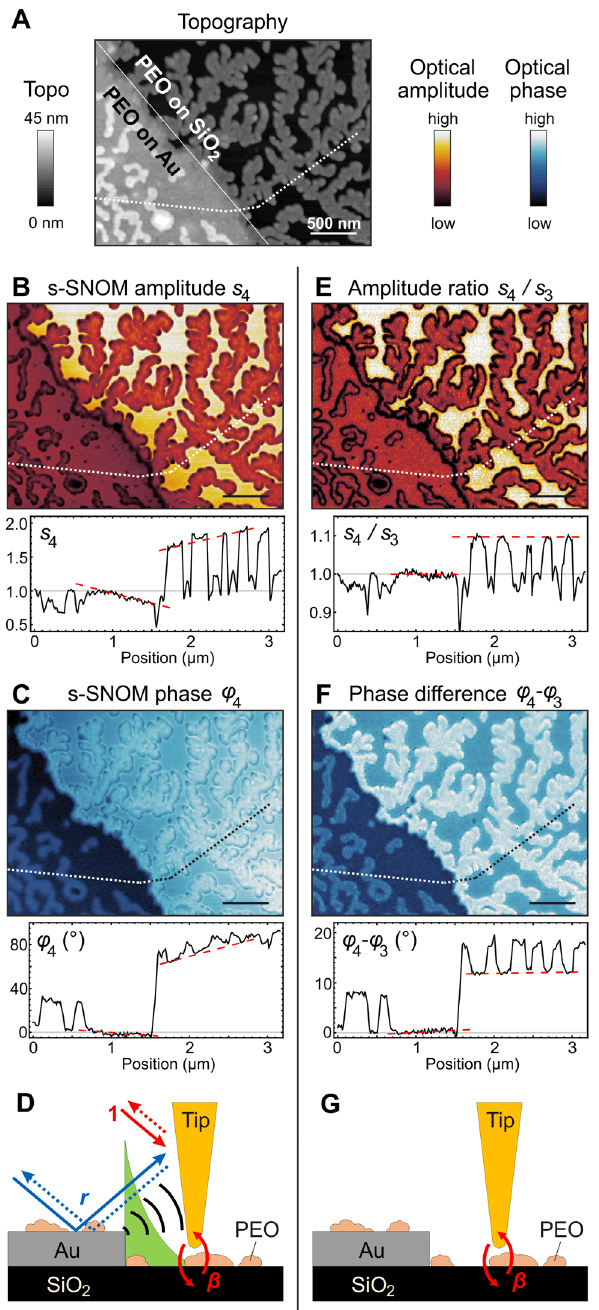
Figure 4: Elimination of material contrast variations induced by tip illumination via the sample surface. (A) Topography, (B) s-SNOM amplitude s 4 , (C) s-SNOM phase φ (E) amplitude ratio s 4 / s 3 and (F) phase difference φ and line pro fi les (taken along the dotted line in the images) of self- assembled PEO on Au and SiO 2 surfaces, recorded with tapping amplitude A =37nm,tipradius R =25nm(PtIrtip,NanoworldArrow- NCPt) and illumination wavenumber ν = 1114cm − 1 . Optical signals are normalized to that of Au. Red dashed lines in the line pro fi les indicate the near- fi eld signals on Au and SiO 2 . (D and G) Illustration re fl ections ( “ r ” ), and near- fi eld re fl ections ( “ β ” ). Scale bars 500